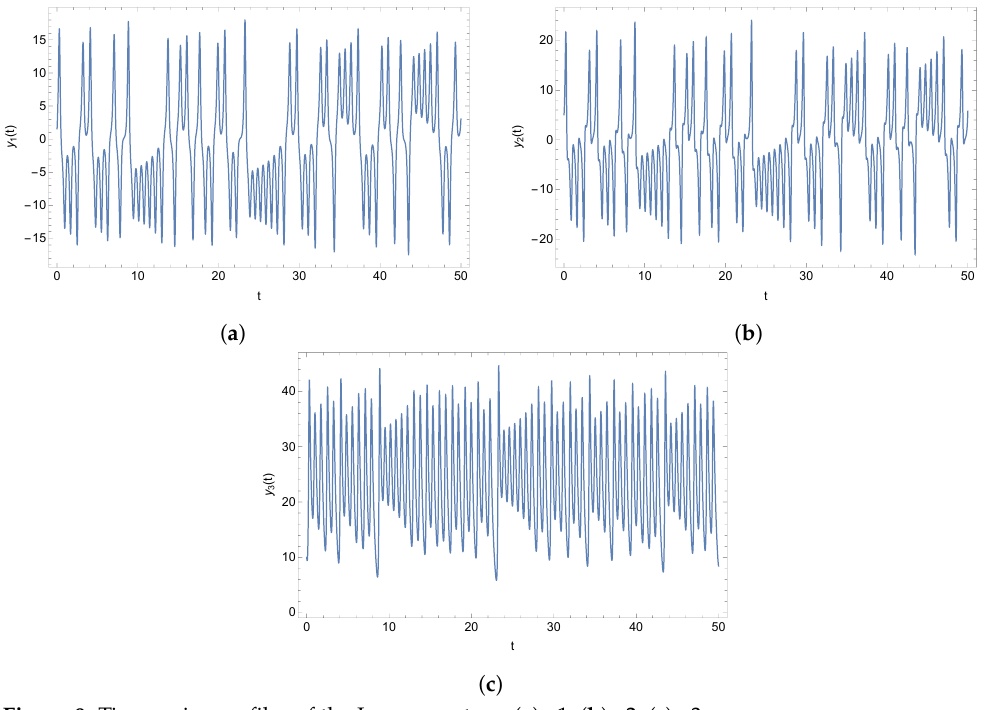
Figure 9. Time series profiles of the Lorenz system. ( a ) y 1; ( b ) y 2; ( c ) y 3.